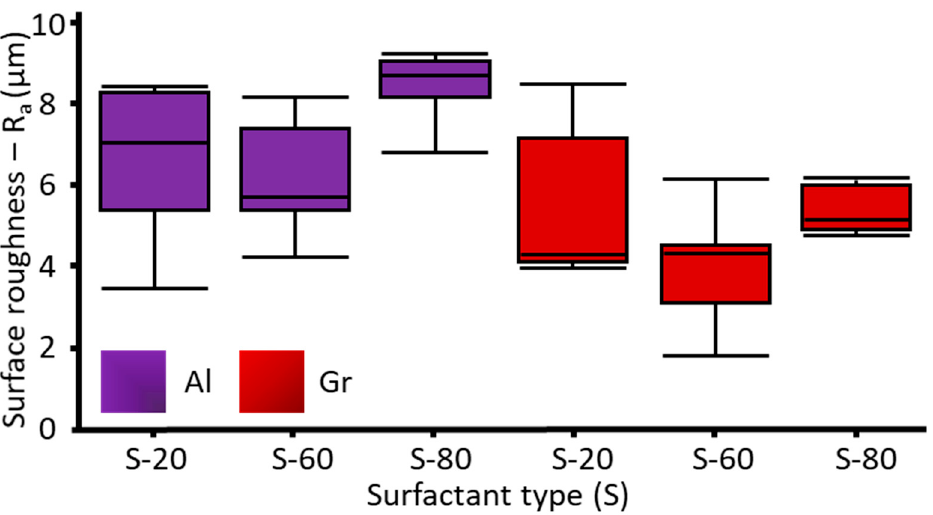
Figure 9. The parametric trend of surface roughness of surfactant type and electrode material (analysis of means of concentrations).